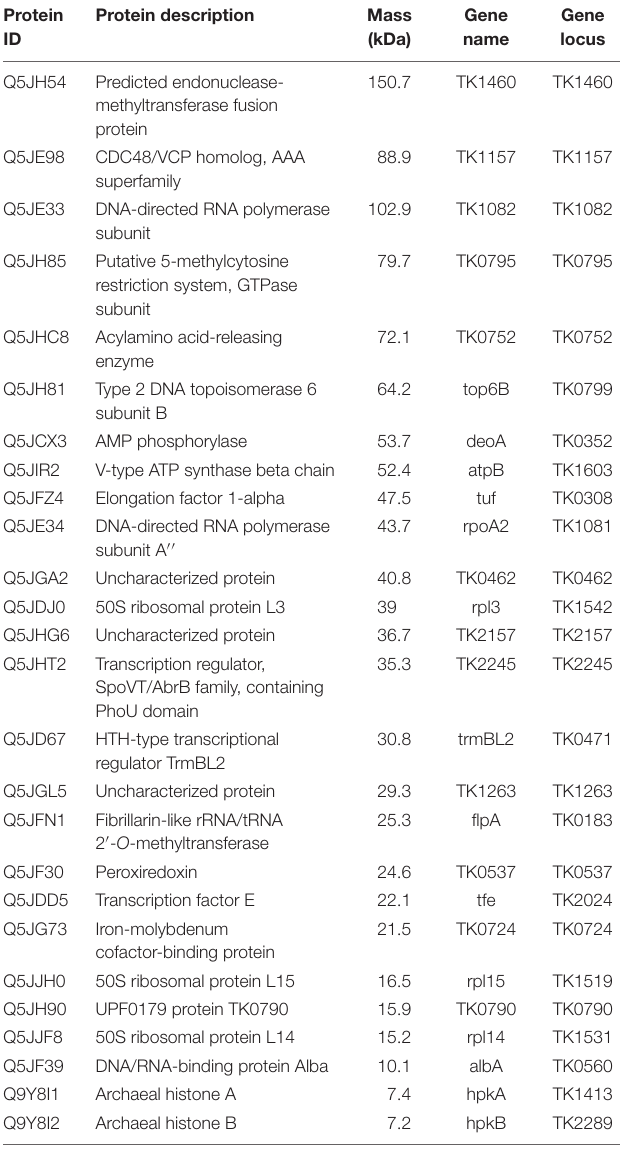
TABLE 3 | Proteins identified by mass spectrometry from isolated chromosomes of Thermococcus kodakarensis. Protein